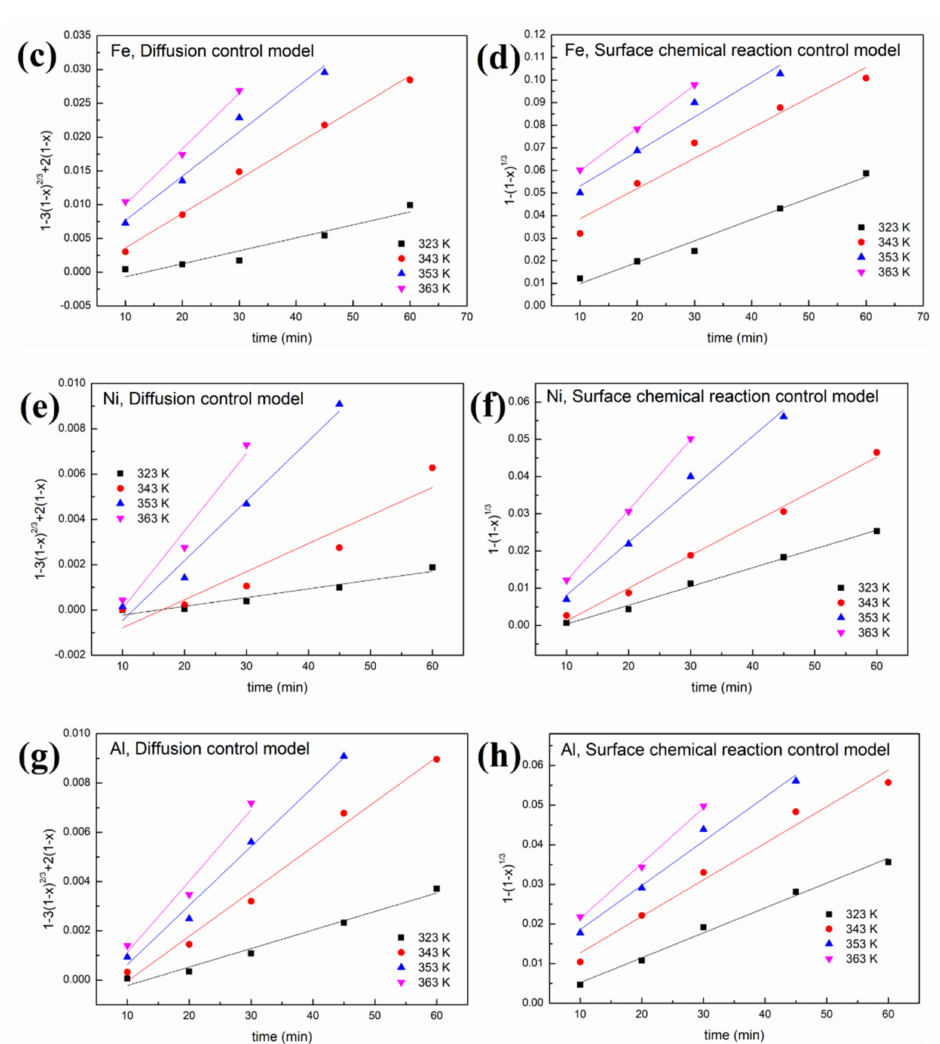
Figure 9. Leaching kinetics of different elements in sulfuric acid: ( a ) V using the diffusion control model; ( b ) V using the surface chemical reaction control model; ( c ) Fe using the diffusion control model; ( d ) Fe using the surface chemical reaction control model; ( e ) Ni using the diffusion control model; ( f ) Ni using the surface chemical reaction control model; ( g ) Al using the diffusion control model; ( h ) Al using the surface chemical reaction control